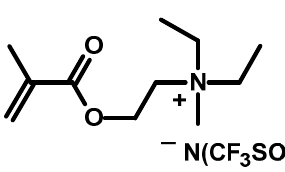
Figure 1. Chemical structure of N , N -diethyl -N -(2-methacryloylethyl)- N -methylammonium bis(trifluoromethylsulfonyl)imide (DEMM-TFSI).